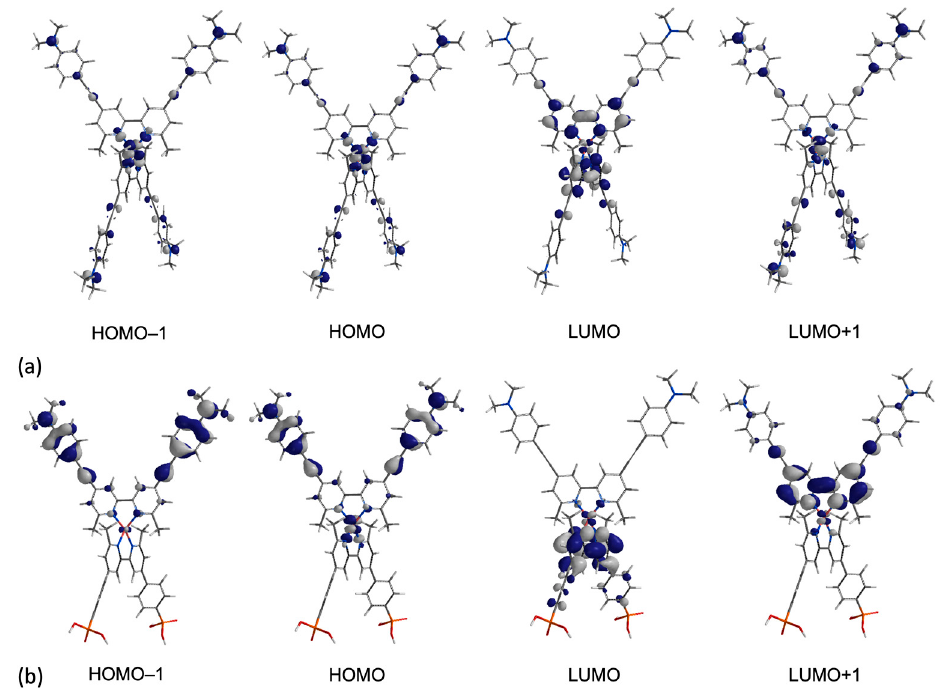
Figure 4. Orbital compositions of the highest occupied and lowest unoccupied molecular orbitals in ( a ) [Cu( 2 ) 2 ] + and ( b ) [Cu( 5 )( 2 )] + calculated using DFT (B3LYP level, 6-31G* basis set, in vacuum). Geometry optimizations were at the same DFT level of calculation.